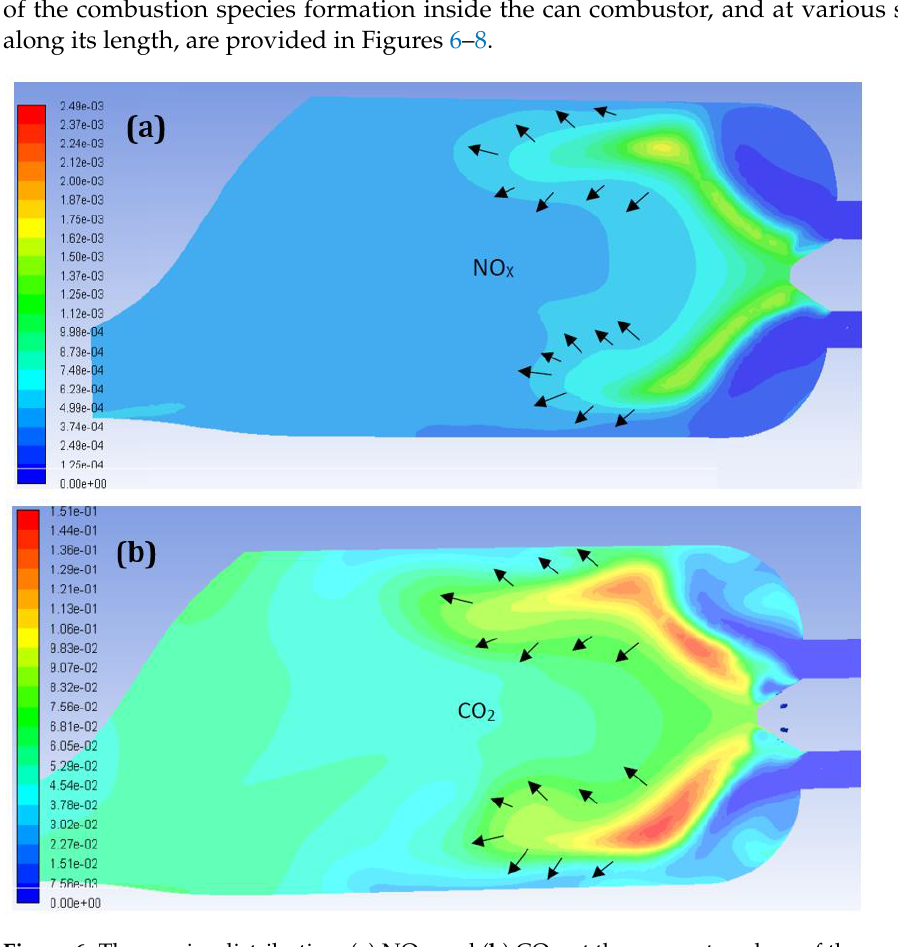
Figure 6. The species distribution, ( a ) NO X and ( b ) CO 2 , at the symmetry plane of the combustion chamber using the suggested kerosene surrogate (53.4% iso-decane and 46.6% cyclododecane). As can be seen from Figure 6, the entrainment of air flow enhances the oxidation of the mixture (suggested surrogate and air) with charge from the dilution holes. The NO X , and CO 2 are at a relatively low level, indicating well-diluted fuel leading to a complete combustion. The above results were obtained for the suggested surrogate. The species distributions were also obtained for the ANSYS kerosene surrogate. The distribution of NO X and CO 2 are shown in Figure 7. It can be seen that the implementation of the detailed combustion chemistry of the suggested kerosene surrogate can lead to lower NO X and CO 2 . This is attributed to the combustion chemistry of the ANSYS kerosene surrogate, which does not include a detailed species generated because of the combustion process. Instead, it includes only 20 species (N 2 , O 2 , C 12 H 23 , CO, CO 2 , H 2 O, H 2 , C, OH, CH 4 , H, O, HO 2 , H 2 O 2 , HCO, CHO, NO, HOCO, C 2 H 6 and HCOOH). Hence, the mass fractions of NO X and CO 2 are higher than those of the suggested surrogate (using the CFSM) with the detailed combustion chemistry.